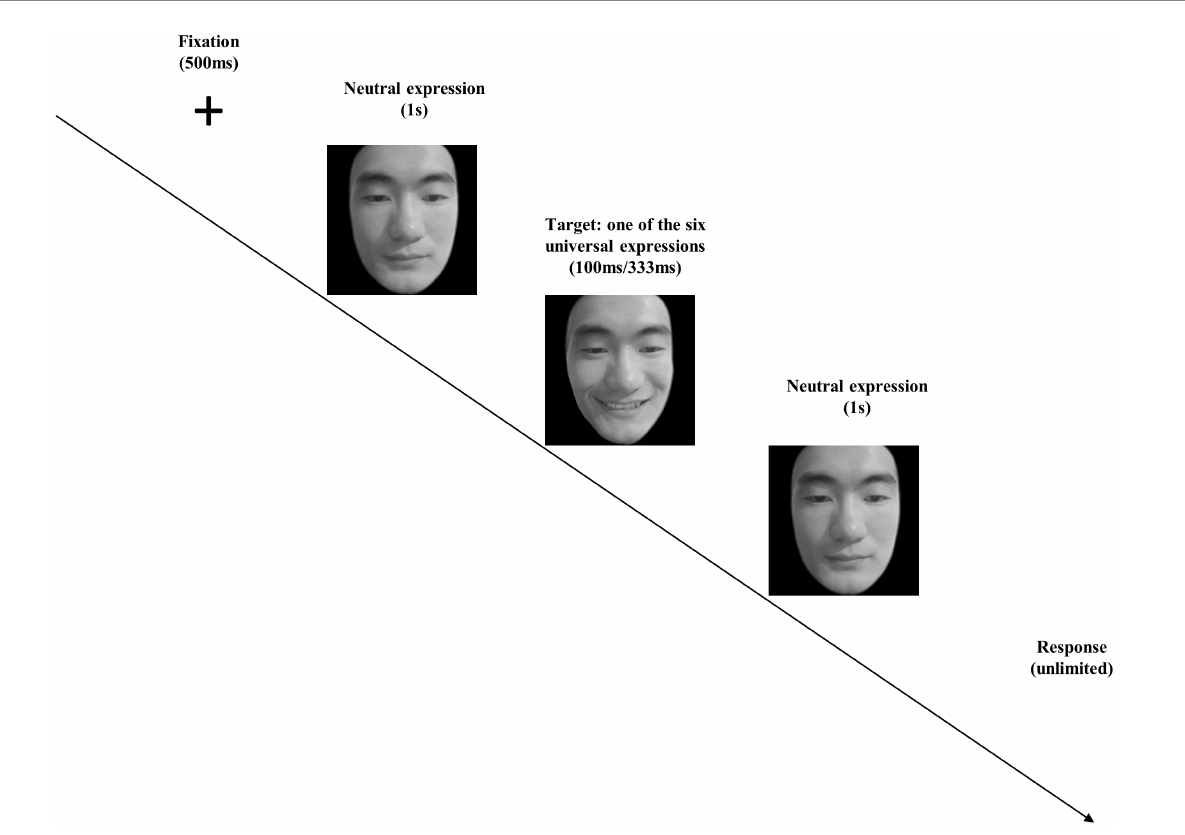
FIGURE 1 The procedure of the micro-expression recognition task in Study 1A. Note that we employ the facial images of the second author for